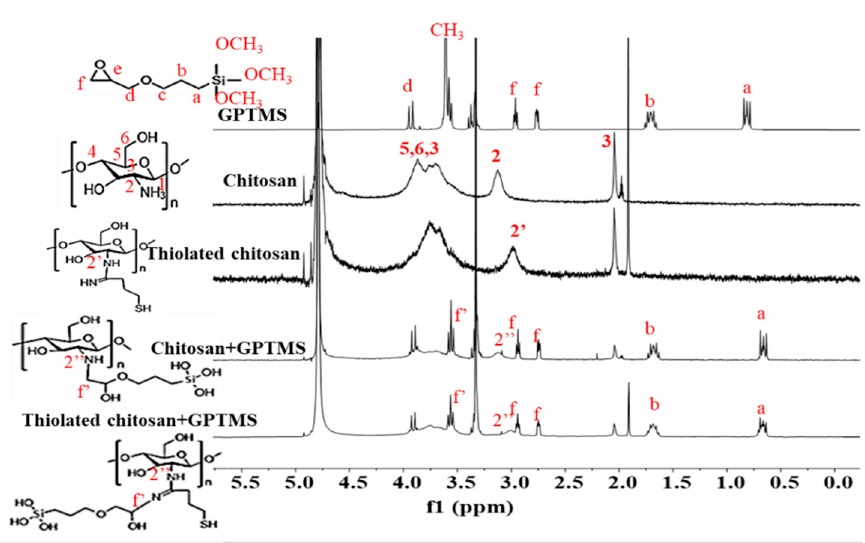
Figure 2. H-NMR spectra of GPTMS and chitosan or thiolated chitosan before and after functional- isation with GPTMS for 24 h in ratio 1:4.